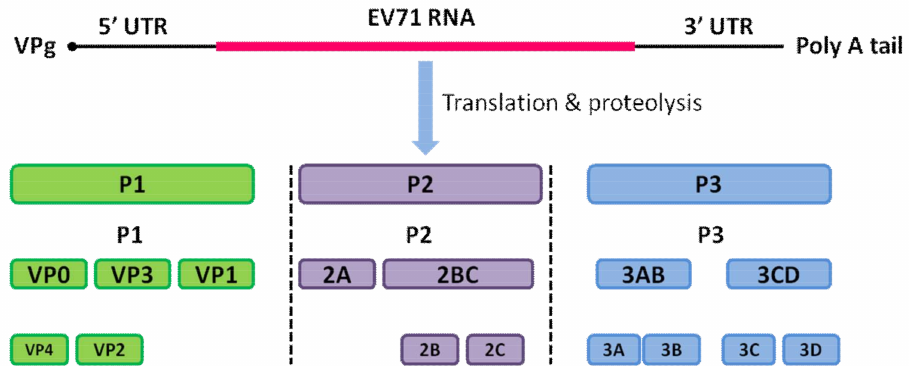
Figure 1. Structure of the enterovirus 71 (EV71) genome. The highly structured 5 (cid:48) UTR and 3 (cid:48) UTR followed by the poly (A) tail control the viral protein translation by binding to the viral VPg protein. This is followed by proteolytic cleavage, and the original protein is matured into four structural proteins, VP1–VP4, and seven non-structural proteins, 2A–2C and